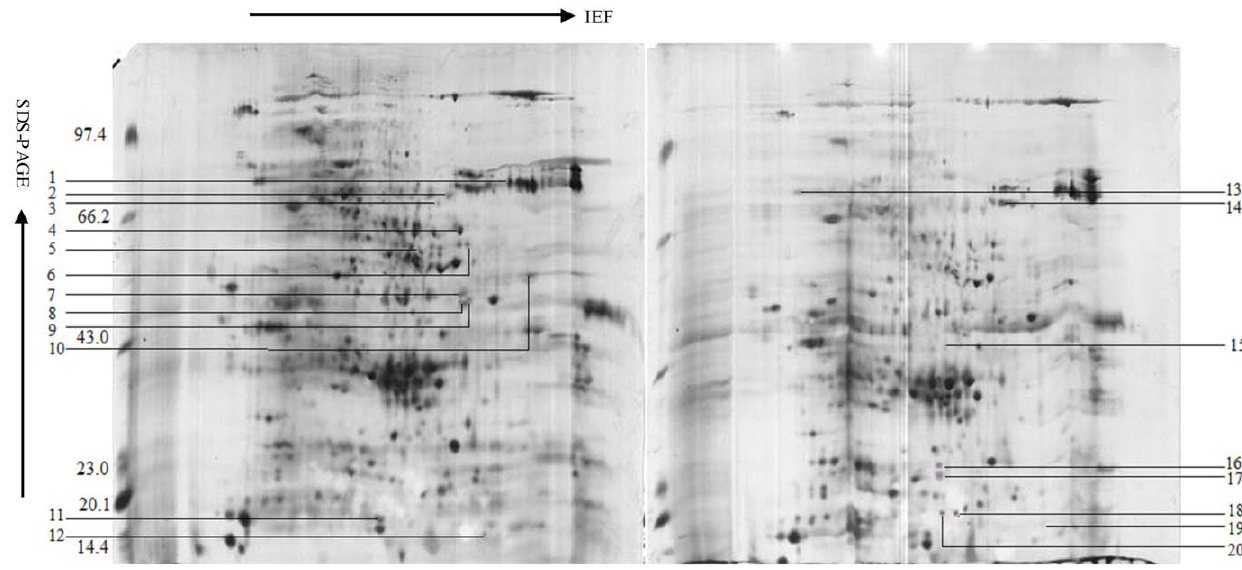
Figure 1. 2DE of mature wheat seeds. The left figure: Yumai 18; The right figure: Transgenic Yumai 18.